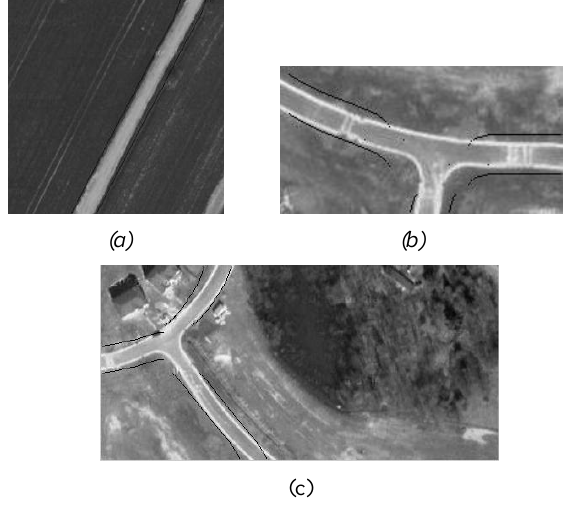
Figure 6: (a), (b) and (c) Other Detected road lines using Ribbon Snake